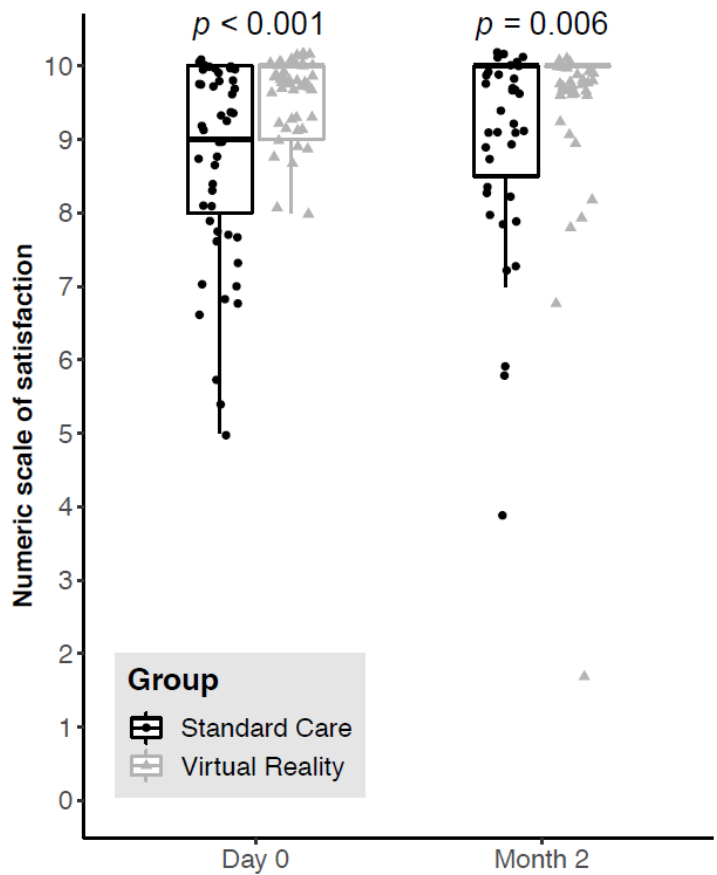
Figure 2. Boxplot graphical representations of the immediate postoperative and 2-month postoperative 10-points satisfaction scores of patients operated before (Standard Care group, dark-grey dots boxplot) and after (Virtual Reality group, light-grey triangles boxplot) virtual reality became available in the department. The upper edge of the box represents the 75th percentile and the lower edge represents the 25th percentile. The vertical length of the box represents the interquartile interval and the central horizontal line represents the median. The upper moustache extends from the upper edge to the highest value at 1.5 times the interquartile space. The lower moustache extends from the lower edge to the lowest value at 1.5 times the interquartile space each dot or triangle represents a patient. Some jittering was added to prevent the overplotting of dots. Please note that in the VR study-group, at month 2, the representation of the boxplot merges with its median.